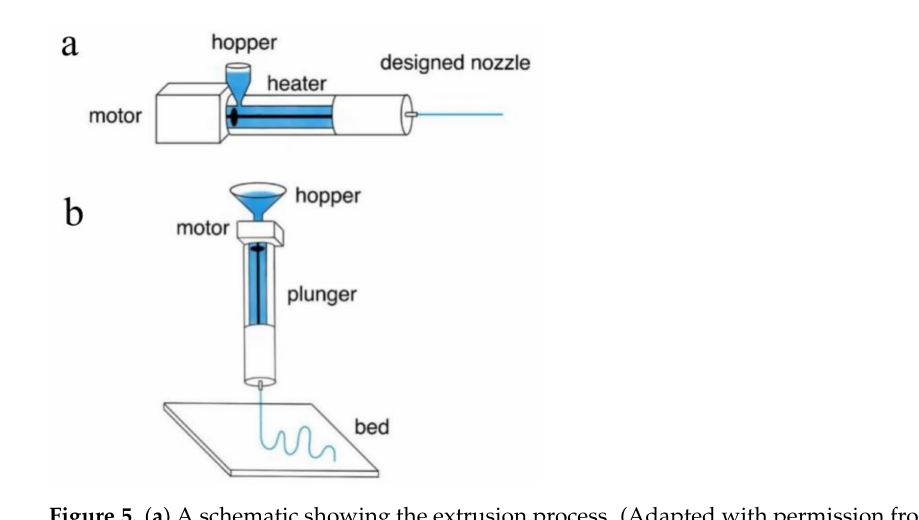
Figure 5. ( a ) A schematic showing the extrusion process. (Adapted with permission from ref. [56]). ( b ) A schematic showing the extrusion-based 3D printing. (Adapted with permission from ref.